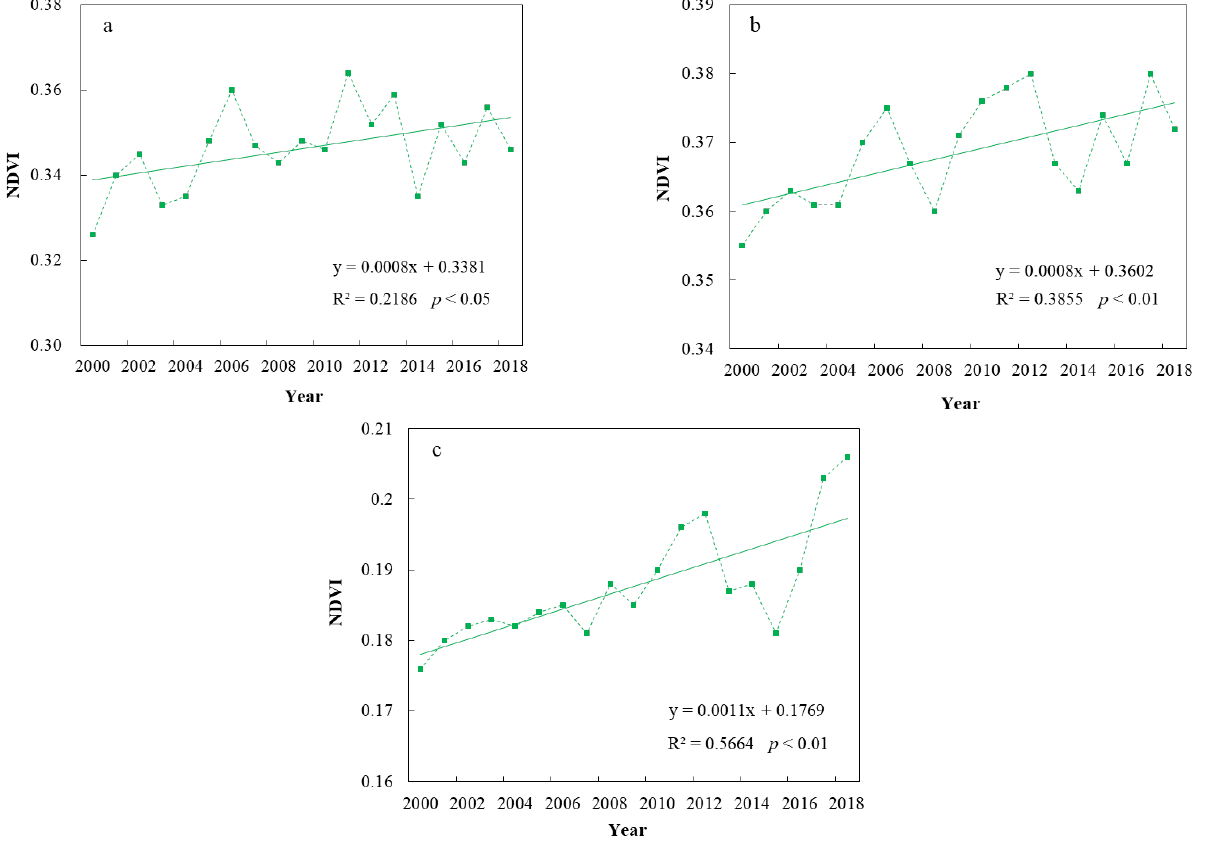
Figure 4. Interannual variation characteristics of the growing season NDVI from 2000 to 2018: ( a ) VQTP, ( b ) AM, and ( c ) AS.